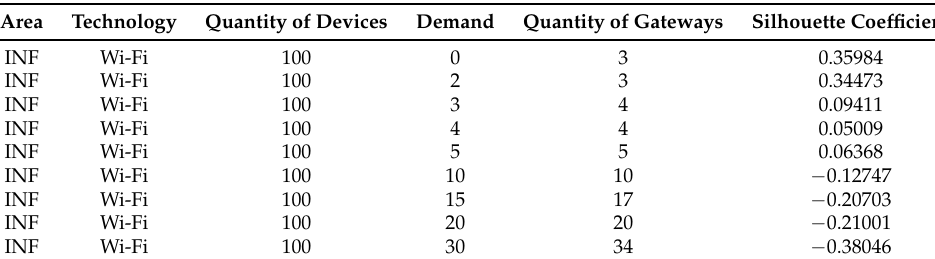
Table 11. The results of the experiments with variations in the demand for data link consumption (LP method).